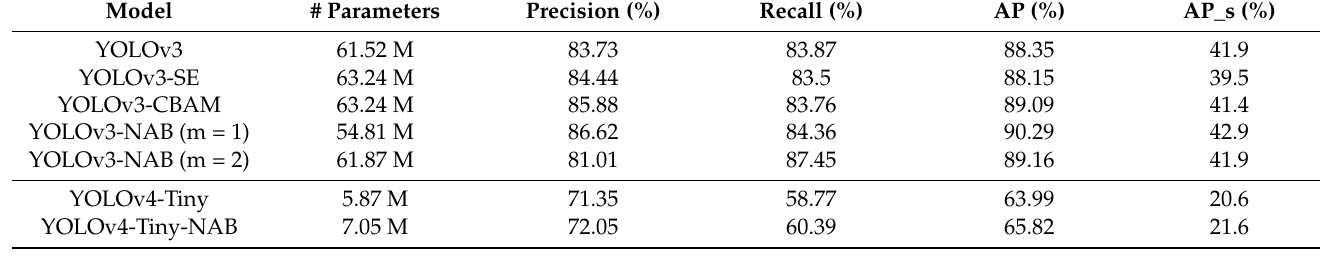
Table 2. Detection results on VHRAI. For a fair comparison, the models based on YOLOv3 had the same configuration. The models based on YOLOv4-Tiny also had the same configuration. YOLOv3-SE and YOLOv3-CBAM adopted the improved ‘CBL5’ with attention mechanisms in Figure 8b.